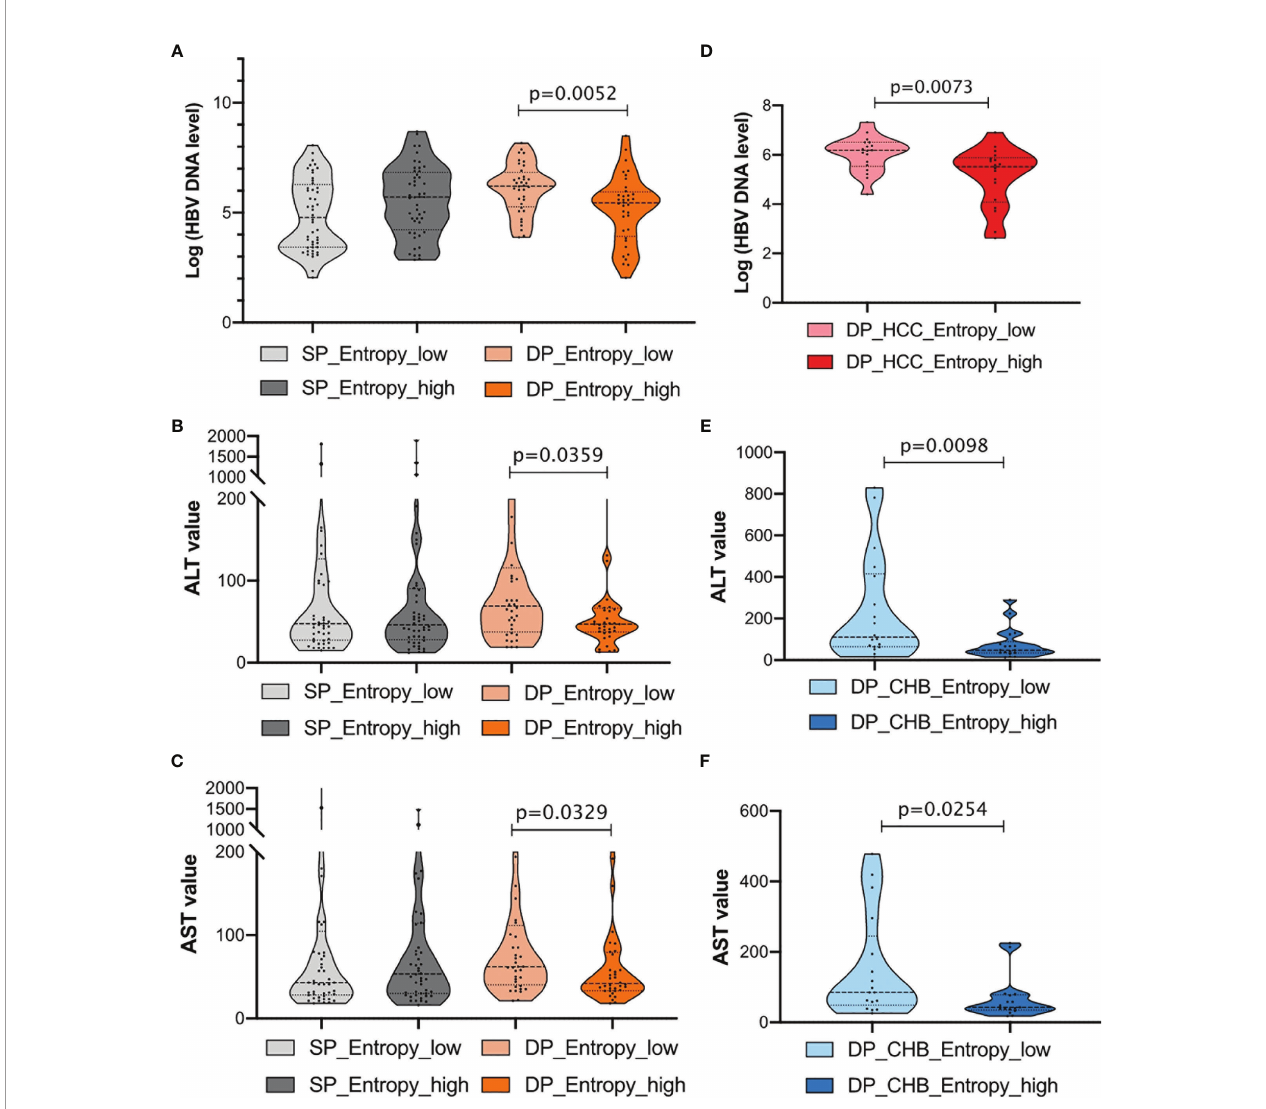
FIGURE 6 | Clinical characterization in double-positive (DP) patients. (A – C) Comparison of HBV DNA log level, alanine transaminase (ALT), and aspartate aminotransferase (AST) values between single-positive (SP) and DP groups. Patients were further classi fi ed into two subgroups, respectively, according to the sum of entropy feature (high, top 50%; low, bottom 50%). The entropy feature based on nucleotide level was marked below, and statistical signi fi cance was evaluated using the unpaired Wilcoxon test. (D) Violin plots demonstrate the relationships between the entropy feature and HBV DNA log levels in HCC_DP groups. Patients were classi fi ed into two subgroups according to the sum of entropy feature (high, top 50%, dark red; low, bottom 50%, light red). (E, F) Violin plots demonstrate the relationships between the entropy feature and ALT or AST values in CHB_DP groups, separately. Patients were classi fi ed into two subgroups according to the sum of entropy feature (high, top 50%, dark blue; low, bottom 50%, light